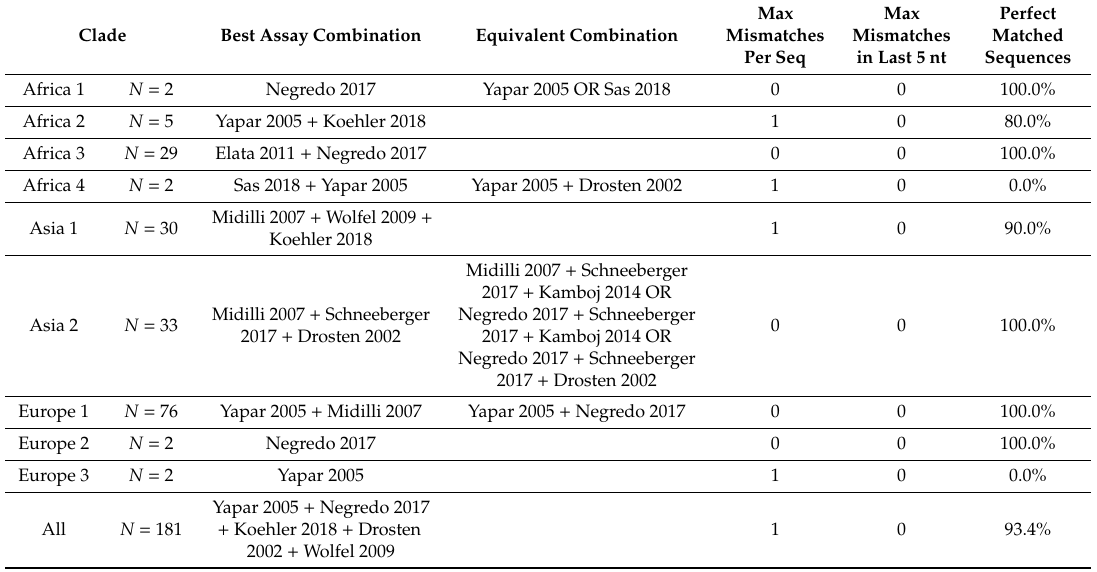
Table 4. Best assay combinations for the CCHFV detection. For each clade, the combination(s) of assays with the best detection e ffi cacy was reported on the basis of the three threshold parameters (see